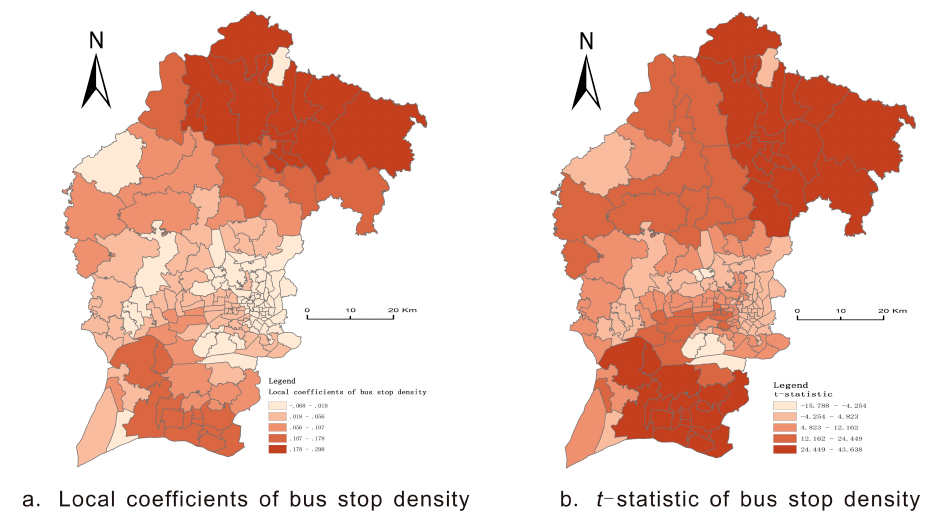
Figure 8. Distribution for local regression coefficients and t -statistics of bus stop density.